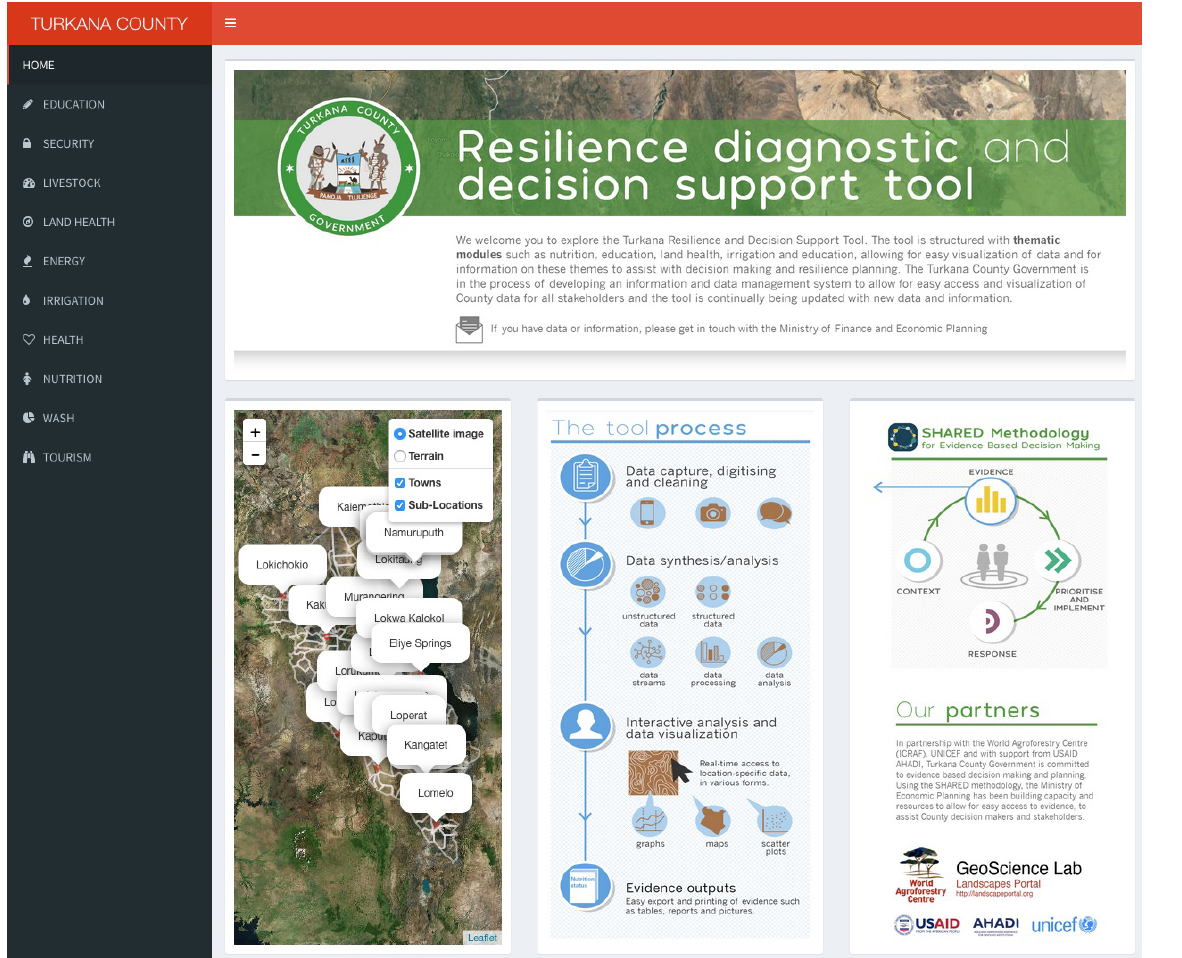
Figure 4. The front page of the Turkana Resilience Diagnostic and Decision Support Tool.